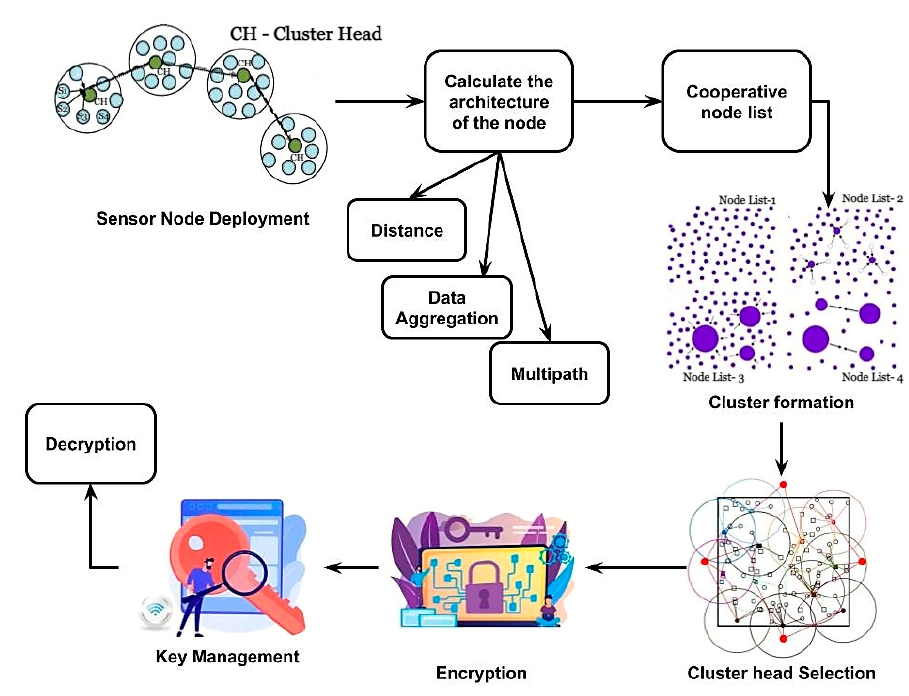
Figure 1. Proposed architecture diagram.